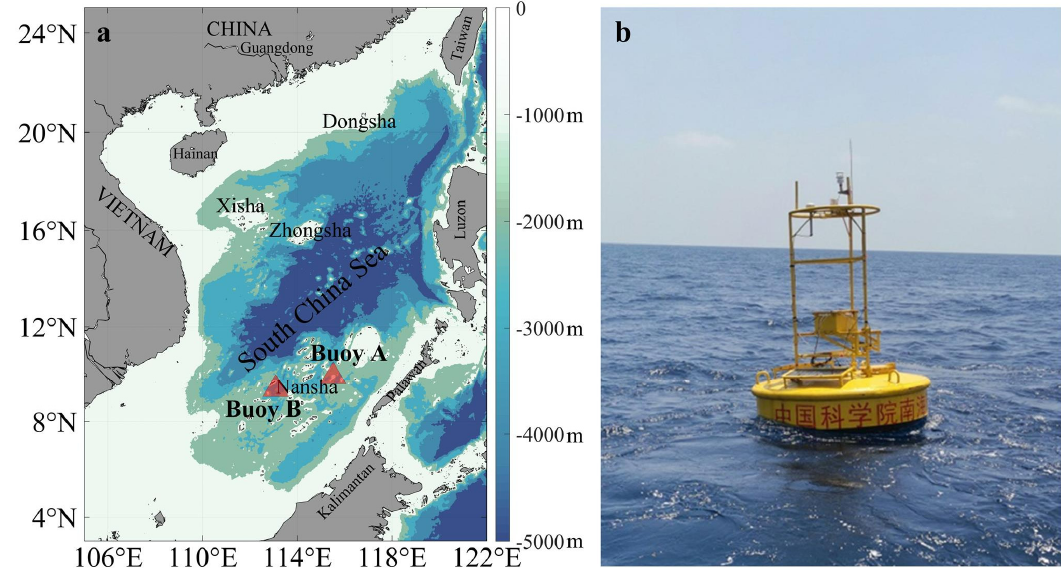
Figure 1. Geography and bathymetry of the South China Sea with the location of the buoys (red triangles) ( a ) and an in-situ photo of the buoy ( b